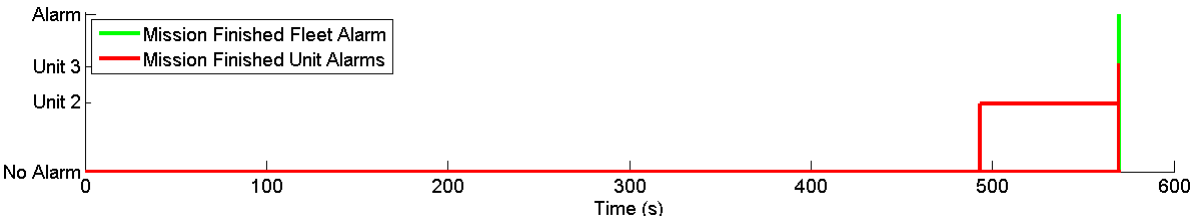
Figure 16. Fleet mission completed supervisor output (green signal) and inputs (red